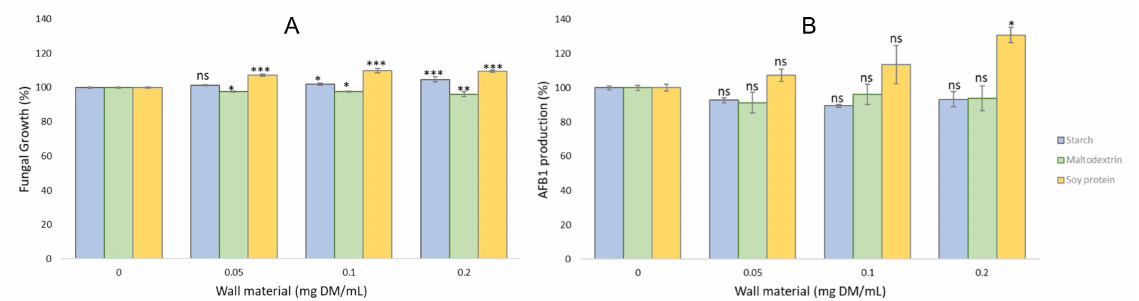
Figure 3. Fungal growth ( A ) and AFB1 production ( B ) of A. flavus NRRL 62477 strain when exposed to increasing concentrations of the different wall-material microparticles for 8 days at 25 ◦ C: Starch (blue bars), maltodextrin (green bars) and soy protein (yellow bars). Columns with 0 correspond to A. flavus NRRL 62477 cultures with no wall materials and are used as control values. Results are expressed as the percentage of fungal growth or AFB1 production compared to untreated control cultures ± standard error of the mean ( n = 4). ns = no significant change; * p- value < 0.1; ** p- value < 0.01; *** p- value <